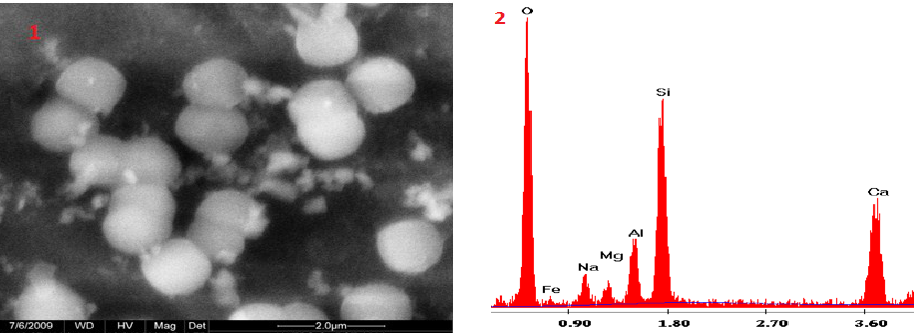
Figure 13. SEM (1) and EDX analysis (2) of the reaction product Z’B4 (synthesized with 4 M NaOH).